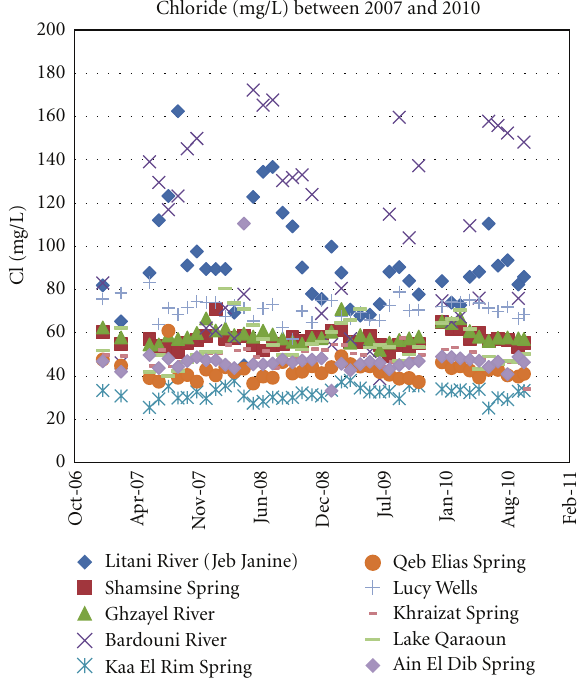
Figure 6: Chloride concentrations for years 2007 through 2010.